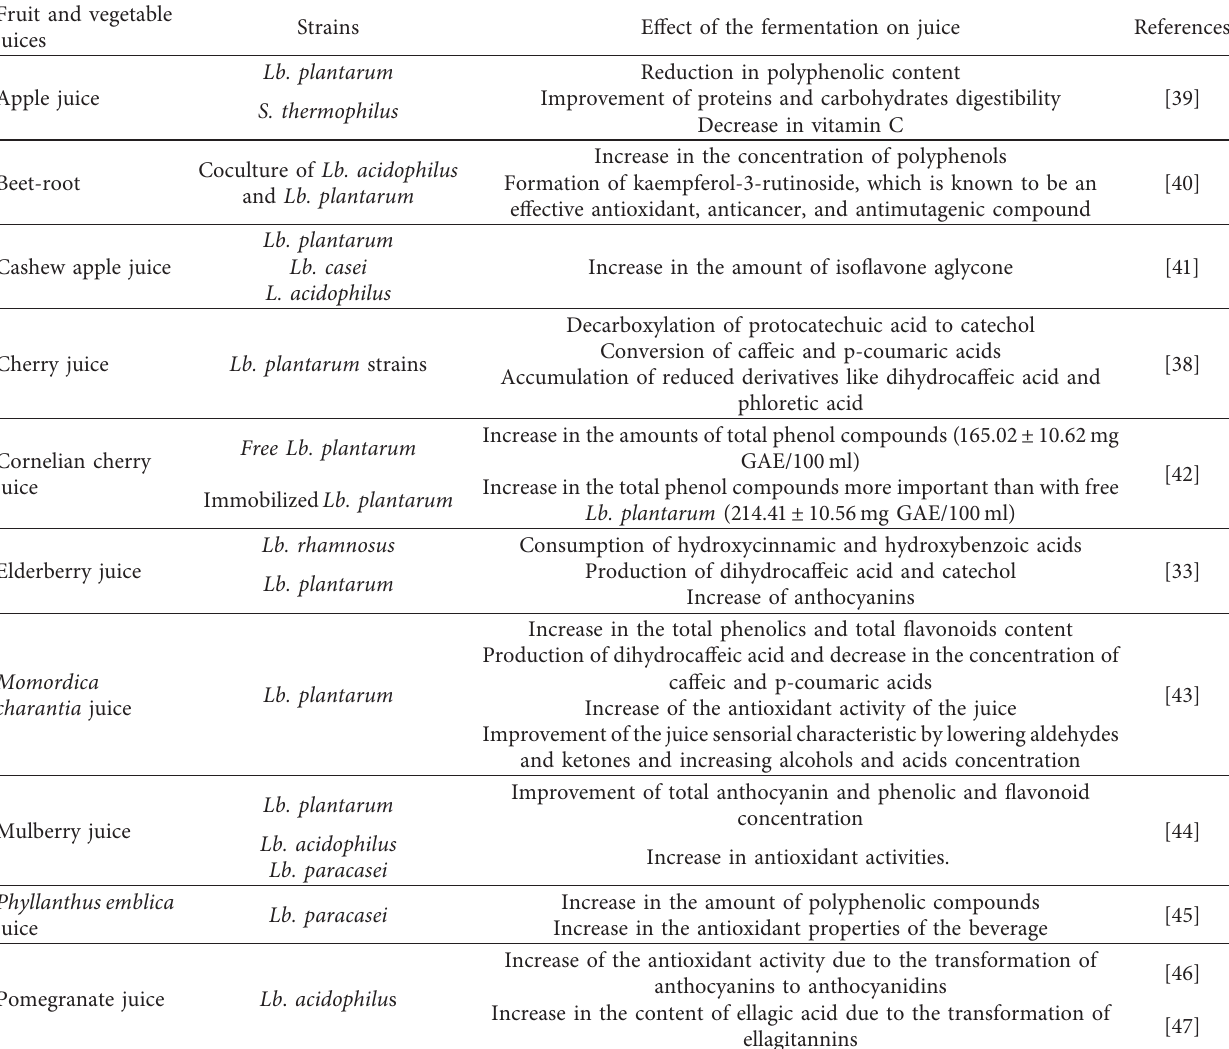
Table 3: Effect of lactic acid fermentation on fruit and vegetable’s